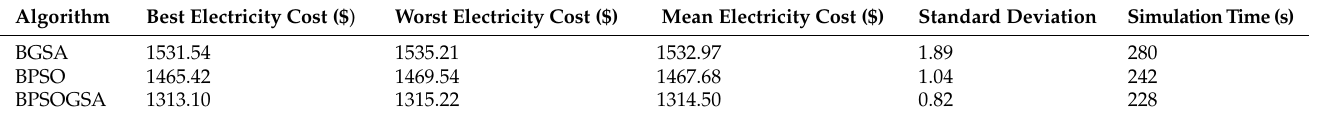
Table 4. Statistical details of algorithms.